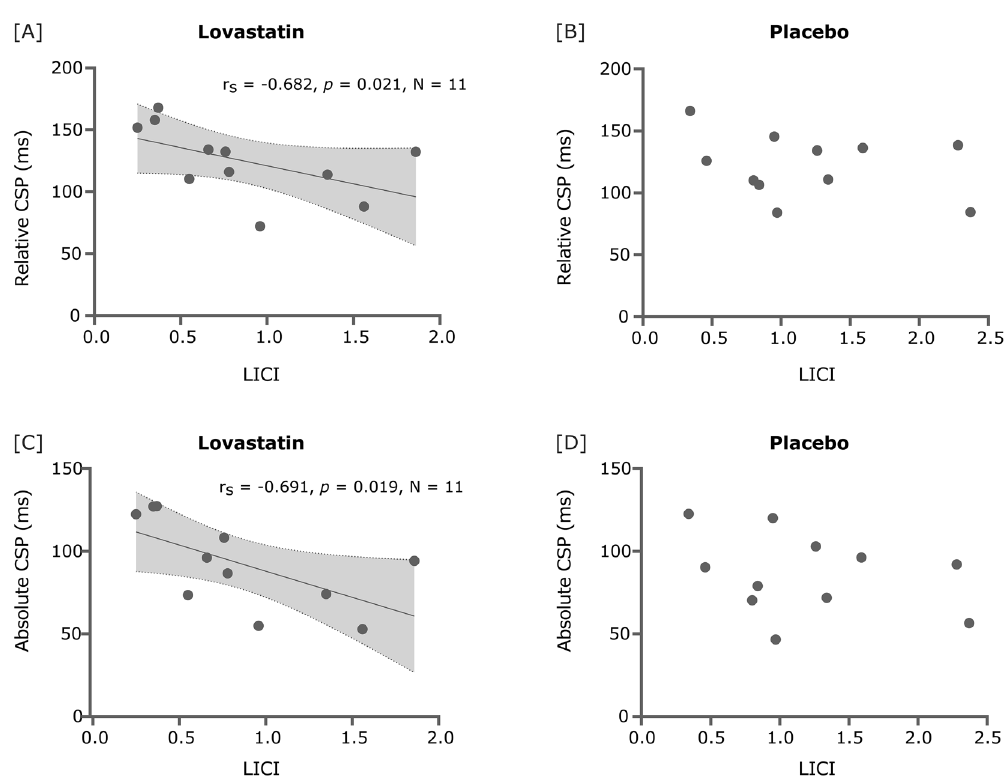
Figure 3. Spearman correlations between relative and absolute silent periods and MEP amplitude ratio in LICI mean intervals, both following lovastatin ( A , C ) and placebo ( B , D ). Shaded area represents the 95% CI for the best-fit line. CSP cortical silent period, ms millisecond, CI confidence interval, LICI long-interval intracortical